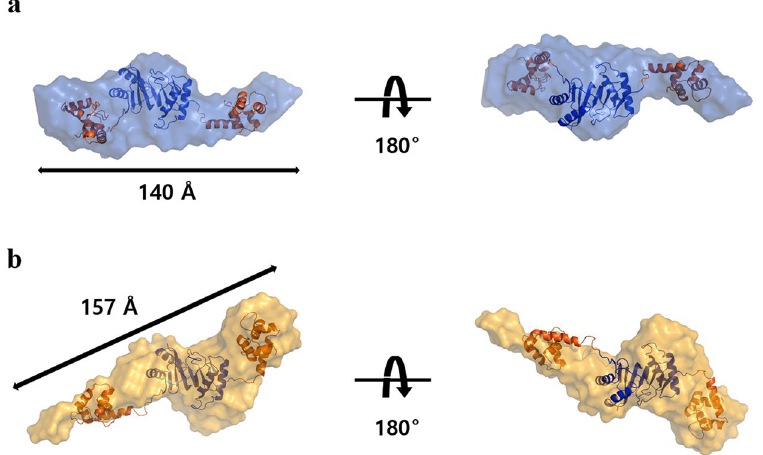
Figure 5. Best-fit ab initio envelopes for the full-length structure of CsTAL3 in solution state. Envelopes generated by DAMMIF are displayed in translucent (a) sky-blue (Ca 2 + -free form) and (b) gold (Ca 2 + -bound